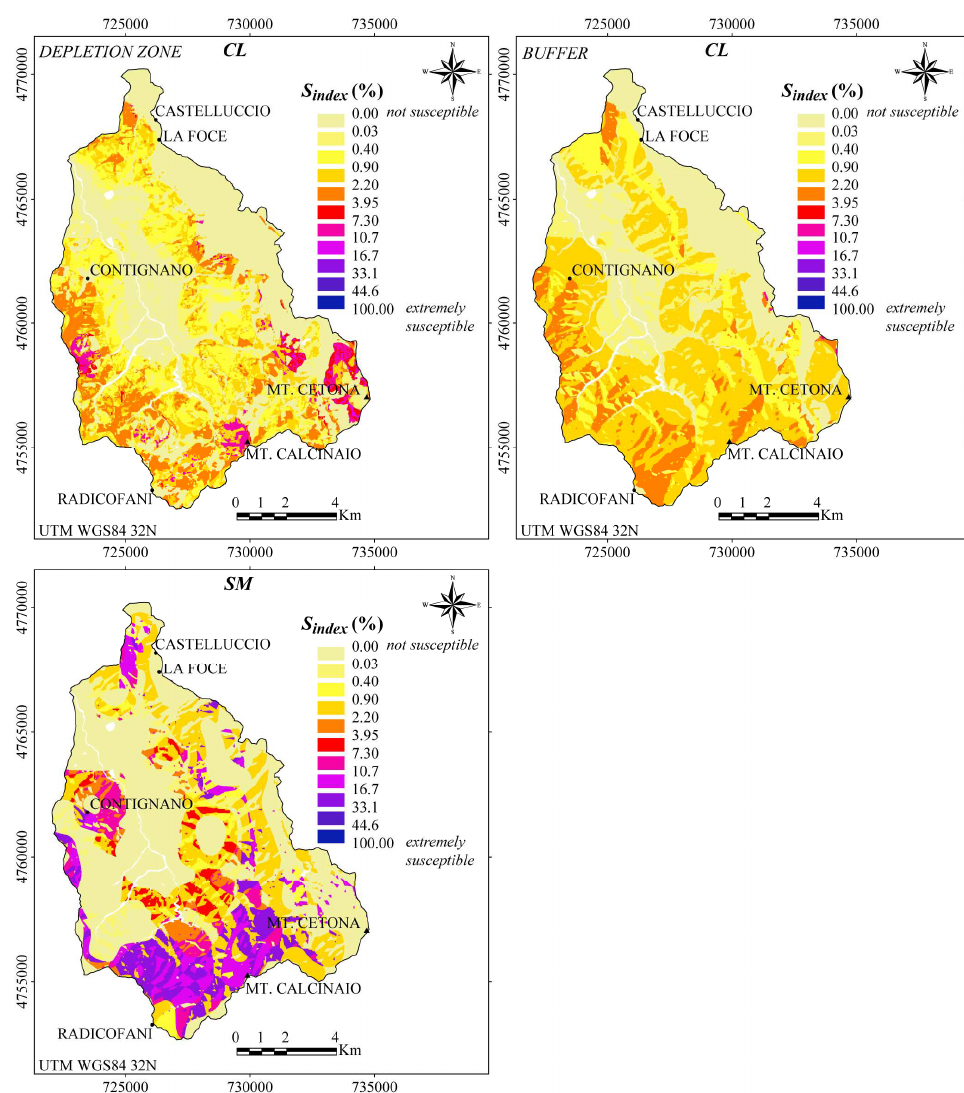
Figure 9: Susceptibility maps of the Upper Orcia Valley obtained through the conditional analysis for each landslide type. For each landslide type, the susceptibility index ( S index ) values correspond to the conditional probability of the landslide event, given the selected number of causal factors. S index values are classified in 11 intervals.